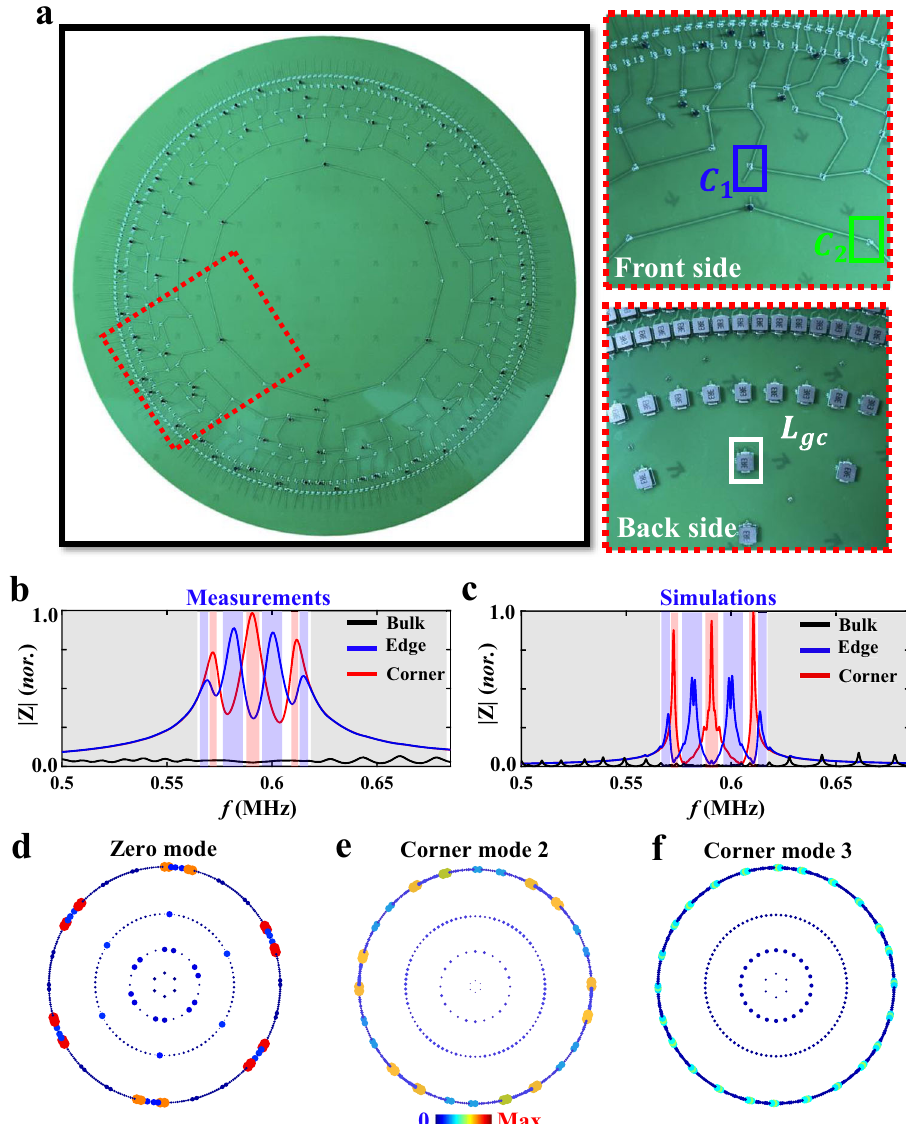
Fig. 4 Observation of higher-order zero modes in the hyperbolic circuit. a Photograph image of the fabricated hyperbolic circuit. Right insets display the enlarged view of the sample as well as the associated schematic diagram. The coupling strength of γ linking circuit nodes through the capacitor C 1 ( C 2 ), as framed by the blue (green) circle. And, each circuit node is grounded by an inductor L gc enclosed by the white block. b , c Measured and simulated impedance responses of selected bulk (black lines), edge (blue lines) and corner (red lines) nodes. d – f The pro fi les of higher-order zero modes and other two 0D corner states of the recovered circuit Laplacian. Circuit parameters used in experiments are set as C 1 = 1 nF, C 2 = 10 nF, and L gc = 3.3